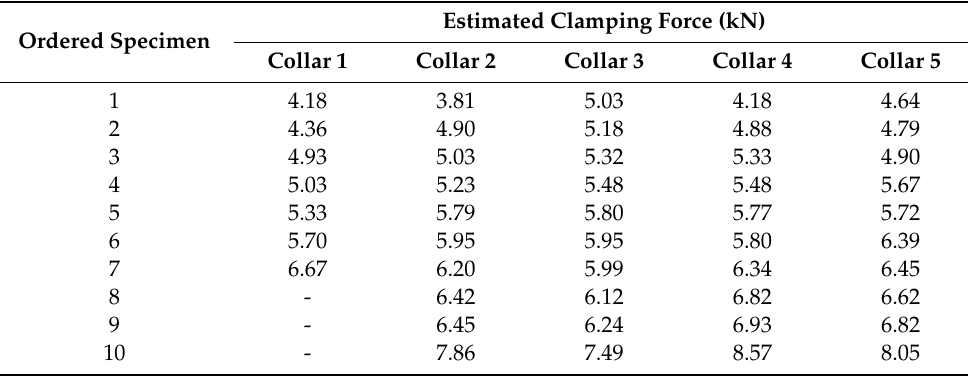
Table A5. Experimental data for clamping force for static tensile tests—Figure